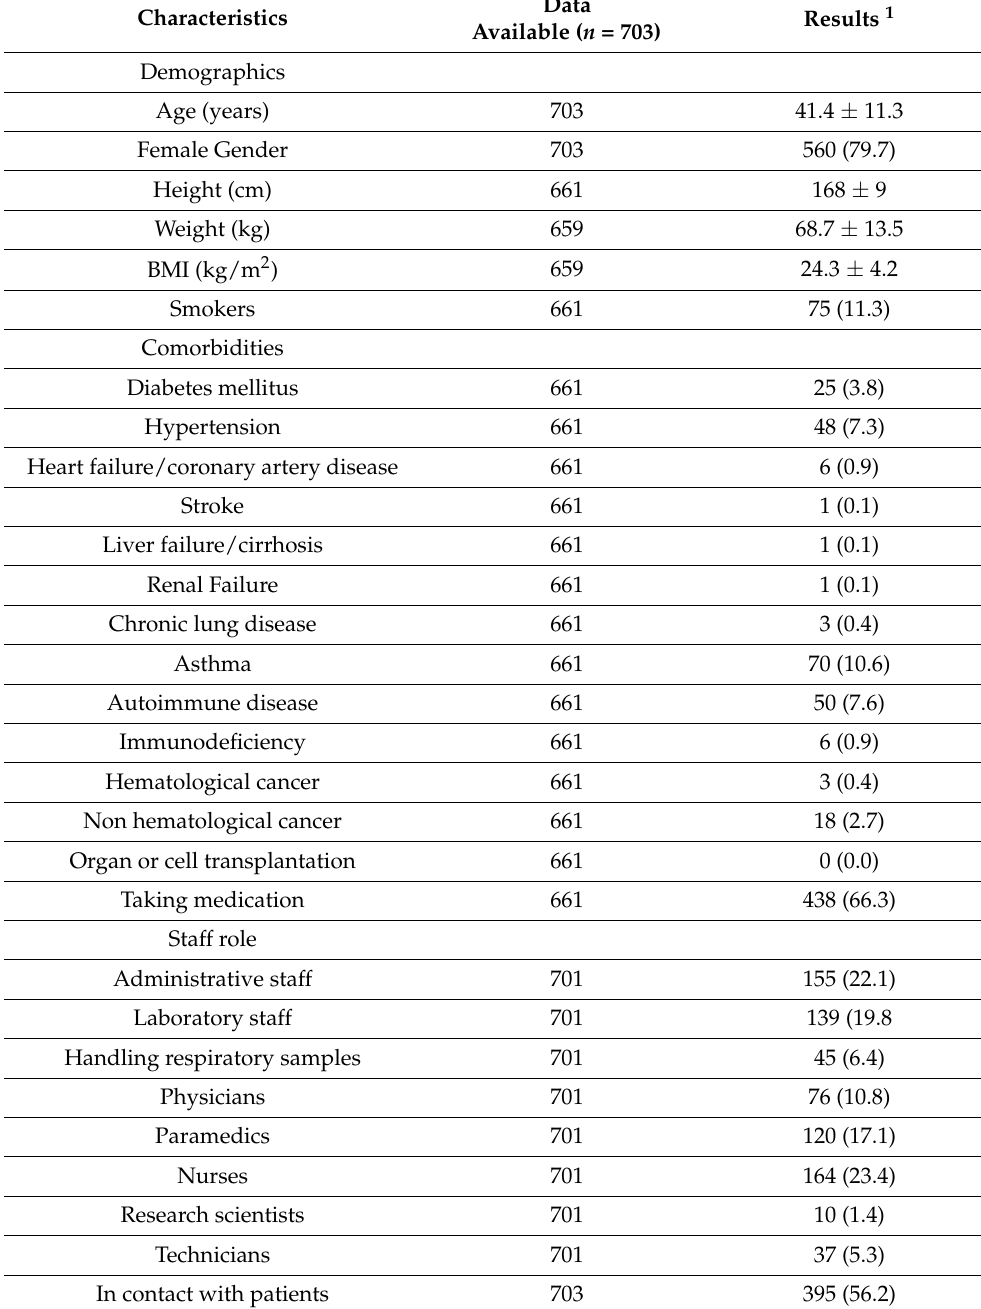
Table 1. Characteristics of the healthcare workers (HCWs) study